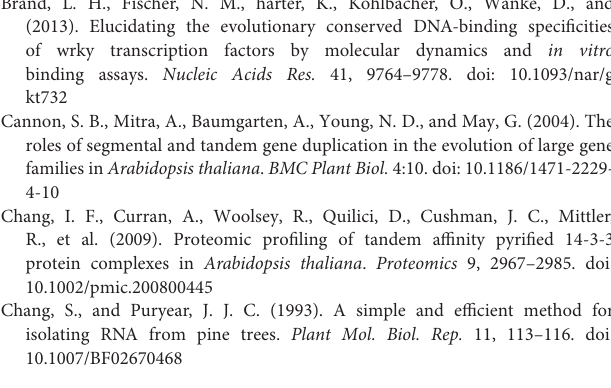
Table S5 | Tests for selection among codons of AiWRKY using branch-site models. ω , Ka/Ks value; ω b0, Ka/Ks value in background Table S6 | The information of AhWRKY genes. Table S7 | qRT-PCR primers in this